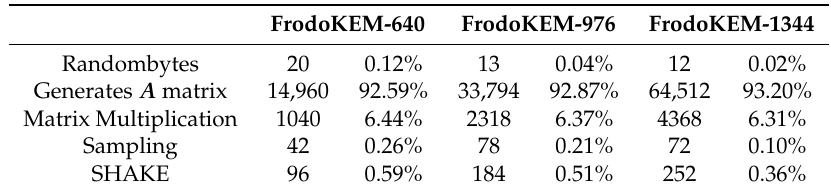
Table 7. Percentage of computational load in FrodoPKE encryption.